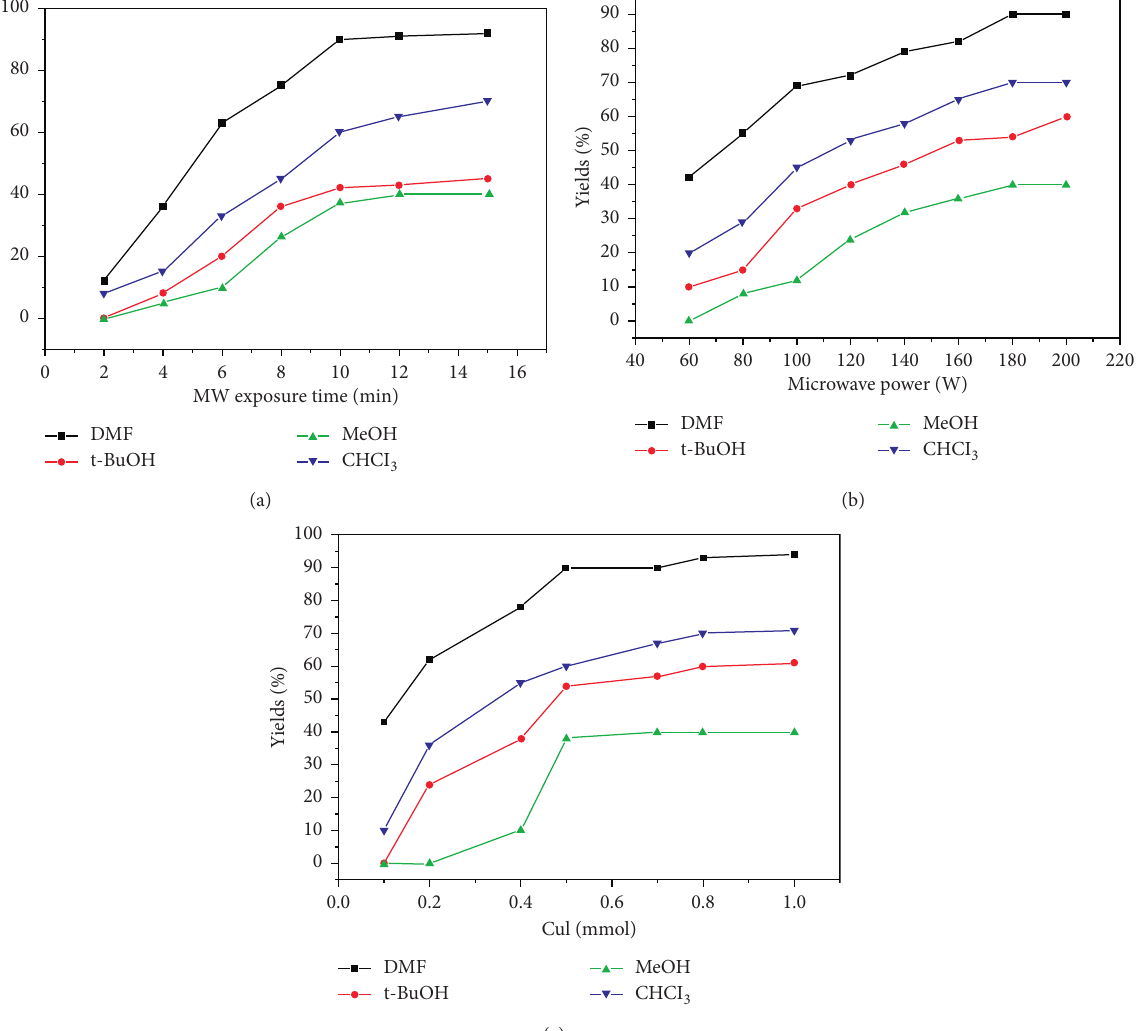
Figure 1: Optimization of cycloaddition reaction by varying (a) MW exposure time, (b) MW power, and (c) CuI